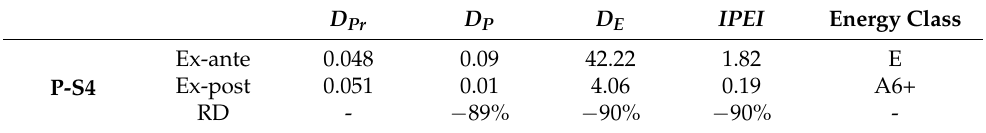
Table 14. Energy performance indicators for ex-ante and ex-post installations of the pedestrian square area (Cassero